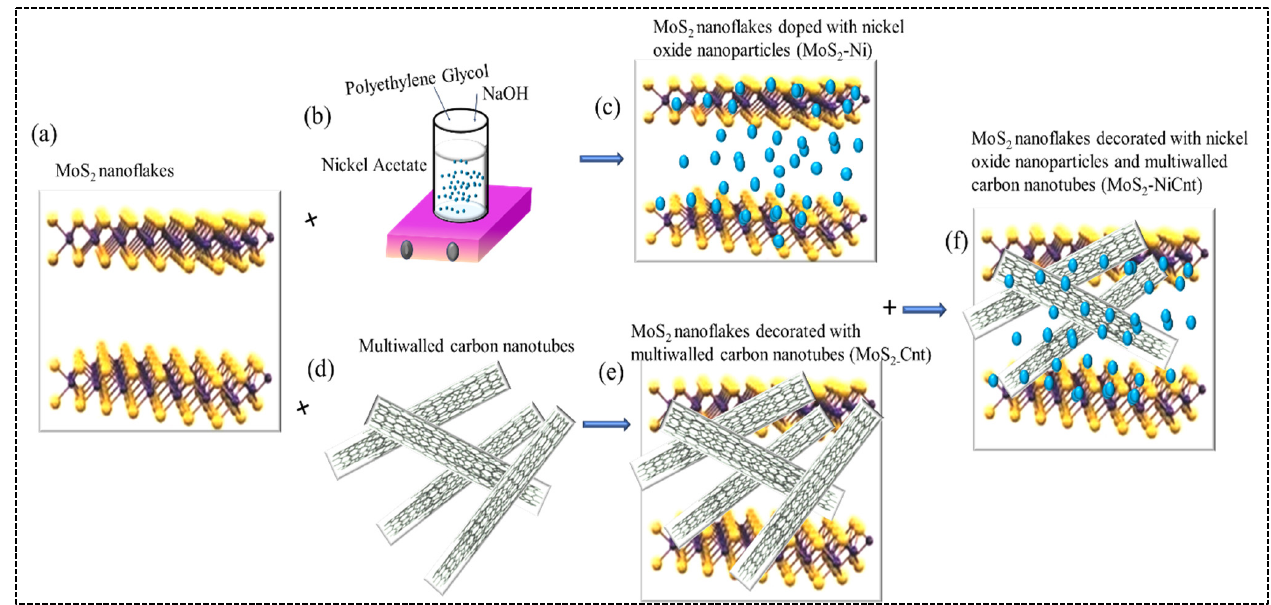
Figure 1. ( a ) Schematic illustration of a few-layer MoS 2 . ( b ) The synthesis scheme of Ni nanoparticles. ( c ) Schematic illustration of the doping of NiO NPs in MoS 2 nanoflakes. ( d ) Multiwalled carbon nanotubes. ( e ) MoS 2 nanoflakes decorated with multi-walled carbon nanotubes. ( f ) MoS 2 nanoflakes decorated with NiO NPs and multi-walled carbon nanotubes.